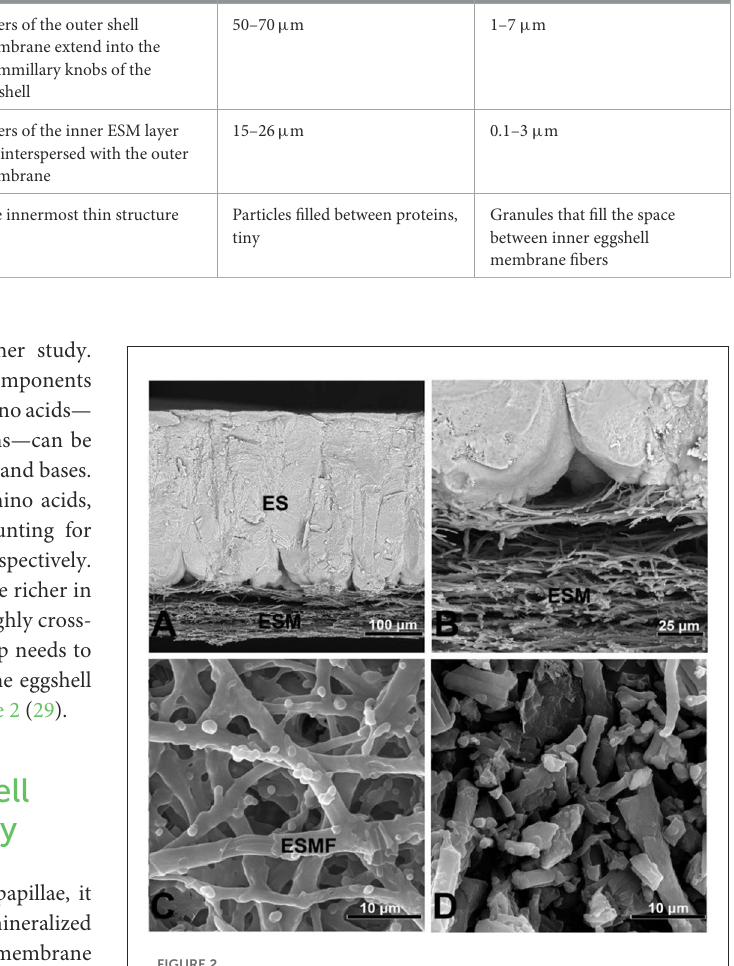
FIGURE2 Scanning electron micrographs illustrating the morphology of the eggshell and eggshell membranes. (A) Eggshell cross-fractured